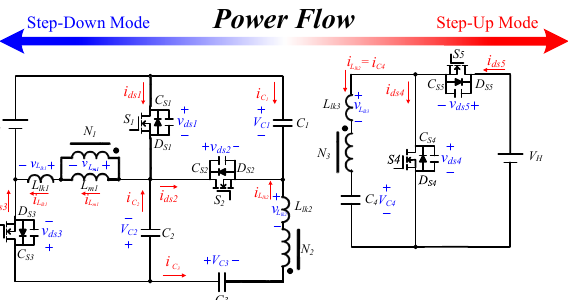
Figure 2. Voltage polarity and current direction of the components of the proposed topology.